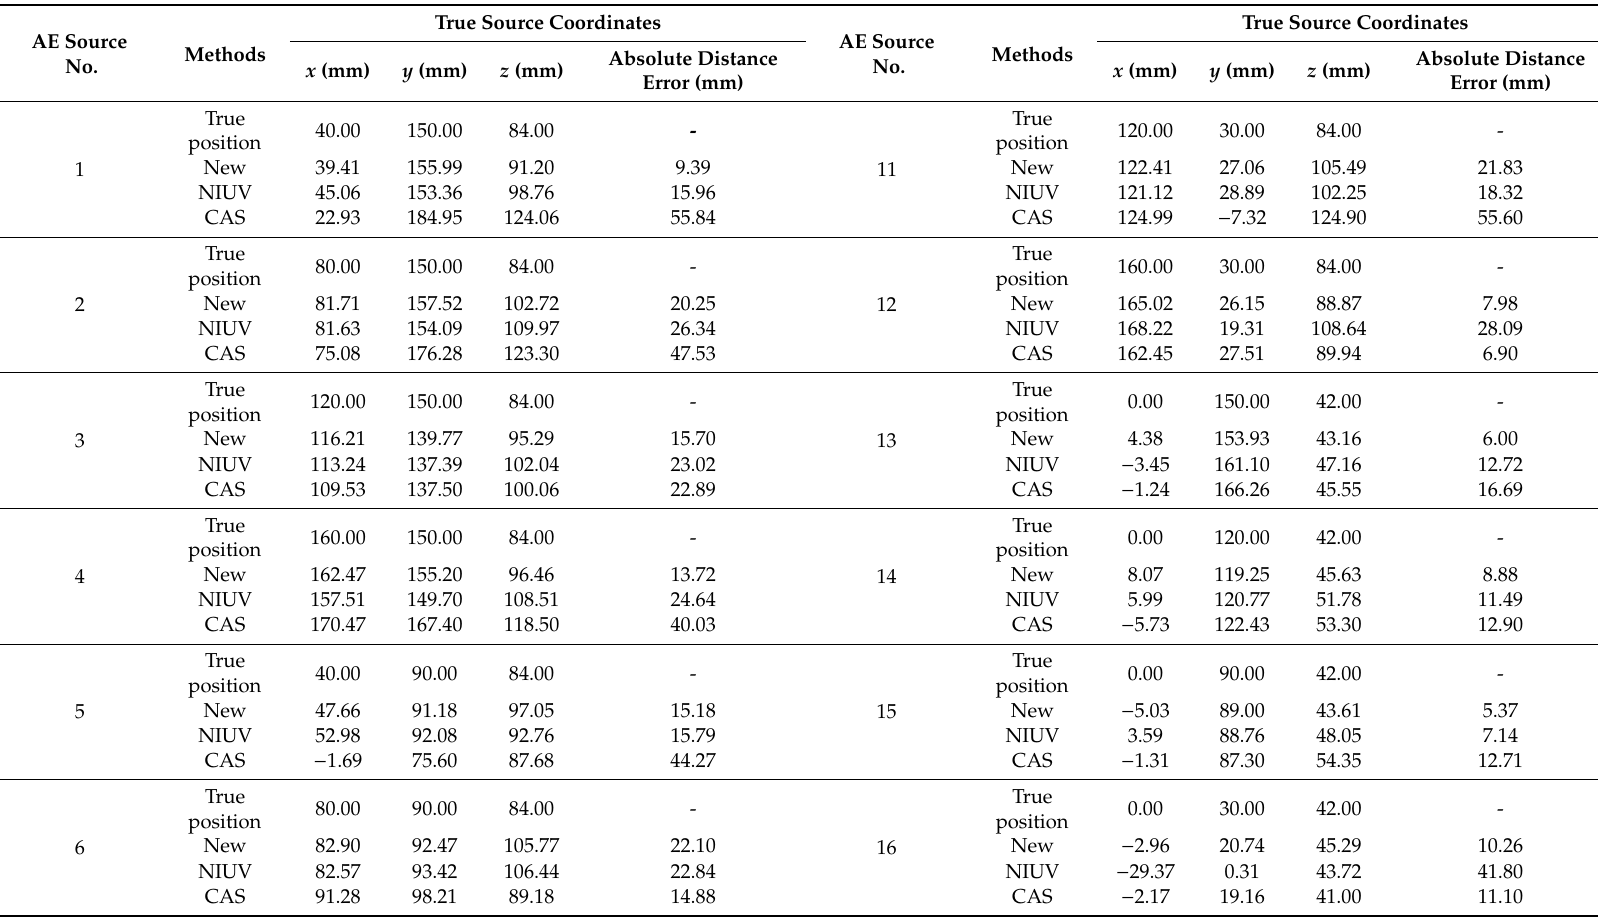
Table 2. Location results of AE sources nos. 1 to 20 solved by three